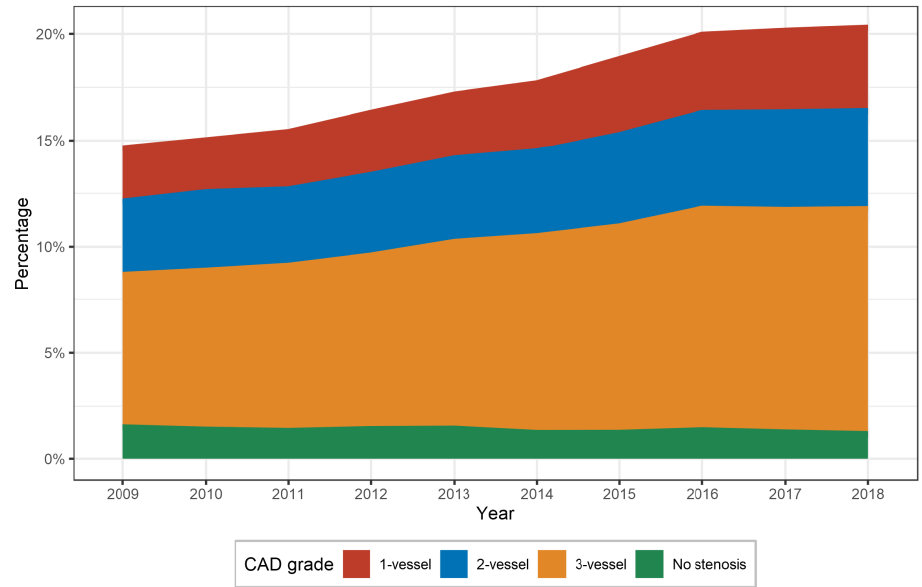
Figure 1. Prevalence of CAD (coronary artery disease) stages in patients hospitalized for peripheral artery disease in Germany between 2009 and 2018.